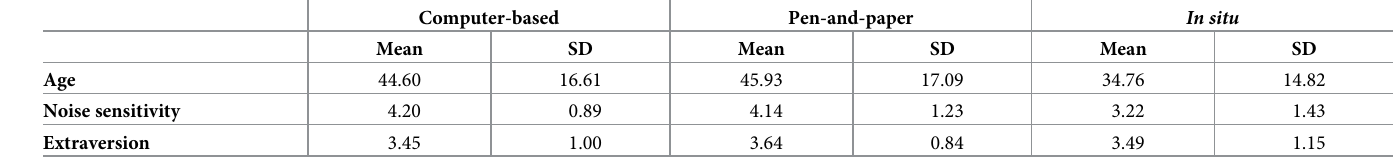
Table 2. Participants’ profile for both laboratory studies (N = 20 and 14, respectively) and in situ (N =